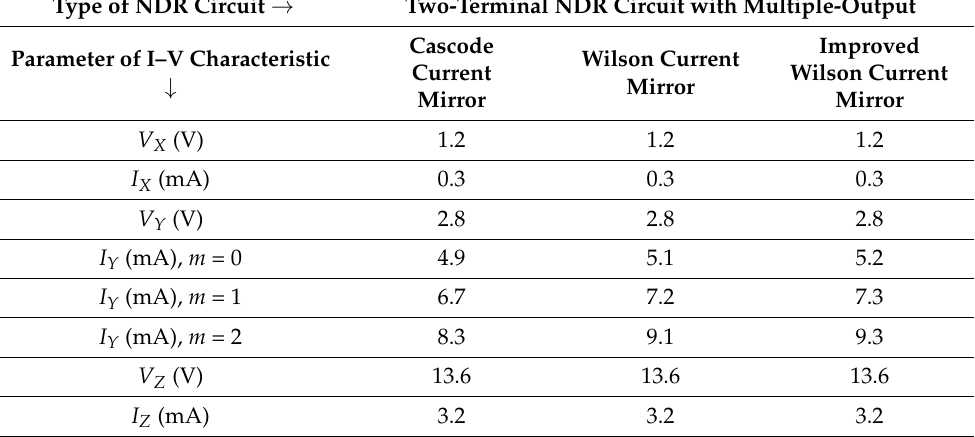
Figure 19. Current-voltage characteristics of the NDR circuit with multiple-output improved Wilson current mirror; m = 0—purple curve, m = 1—blue curve, m = 2—red curve. Table 4. Simulated parameters of current-voltage characteristics for different two-terminal NDR circuits ( T 0